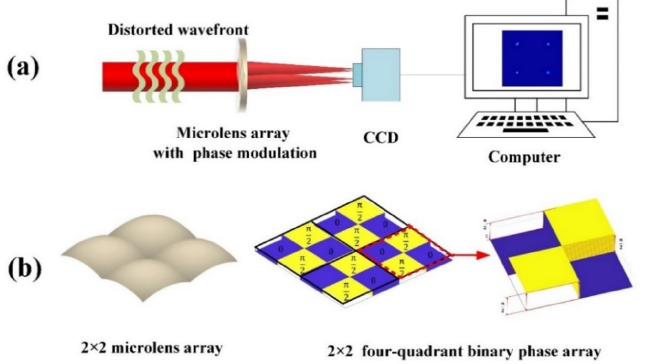
Figure 1. Schematic of the optical structure for the FBPM-SHWFS. ( a ) FBPM-SHWFS. ( b ) Four-quadrant binary phase-modulated microlens array. The left is a 2 × 2 microlens array and the right is a 2 × 2 four-quadrant binary phase.